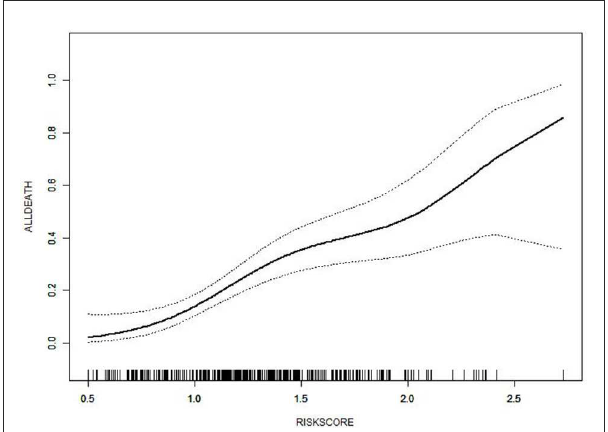
FIGURE2 Relationship between risk score and in-hospital